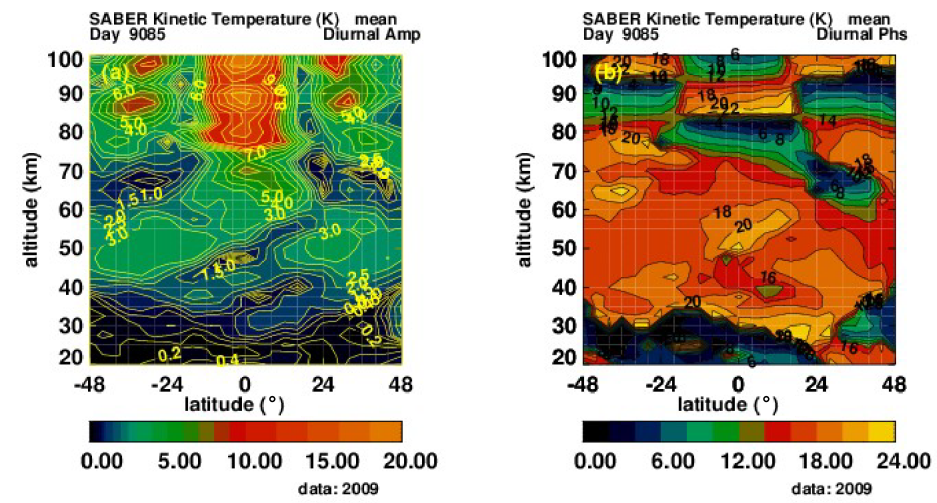
Figure 1. Temperature tides from 20 to 100km, 48 ◦ S to 48 ◦ N, day 85, year 2009. (a) Diurnal amplitudes (K). (b) Diurnal phases (h of maximum